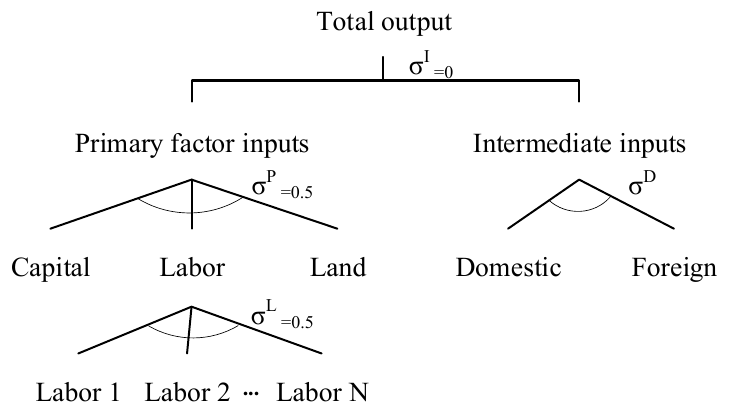
Figure 3. The nesting structure of the production inputs of sectors. Source: the authors.